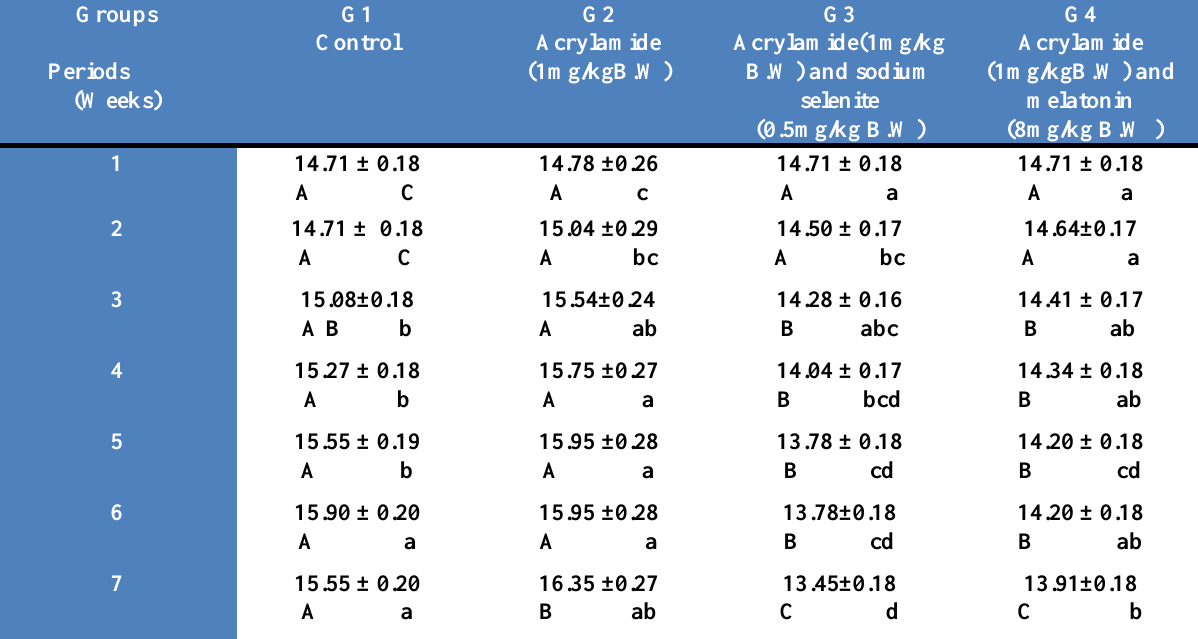
Values are expressed as mean ±SE, n=5. Different small letters represent significant difference within group (P<0.05) vs. zero time .Different capital letters represent a significant difference between groups (P<0.05) vs.